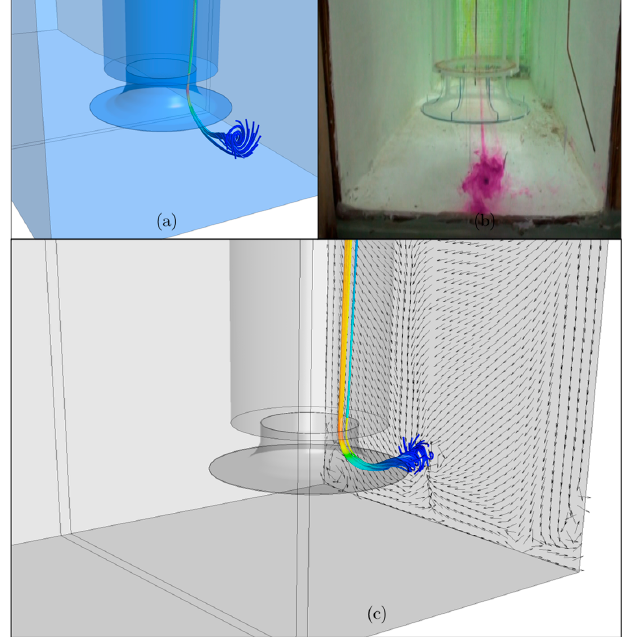
Figure 15. ( a ) strong sub-surface vortex attached to the backwall of the sump. ( b ) floor vortex as photographed during the physical model test. ( c ) vector plot showing flow direction near the backwall.